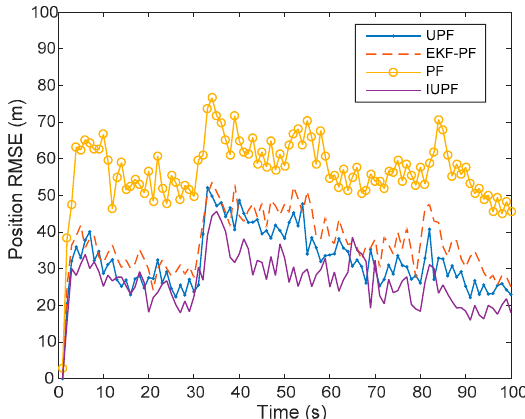
Figure 8. Comparison of position root mean square error (RMSE) in a single-target simulation experiment. Table 2. Comparison of average data in a single-target simulation experiment